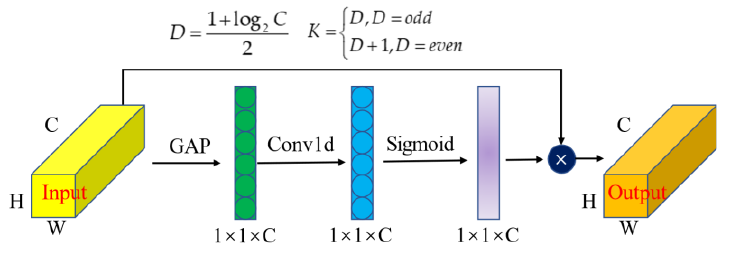
Figure 3. The structure of the ECA block.